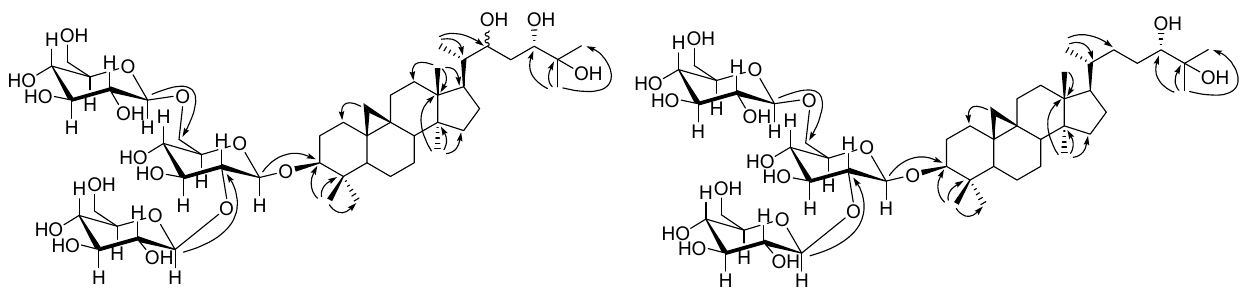
Figure 2. Key HMBC correlations of 1 and 2